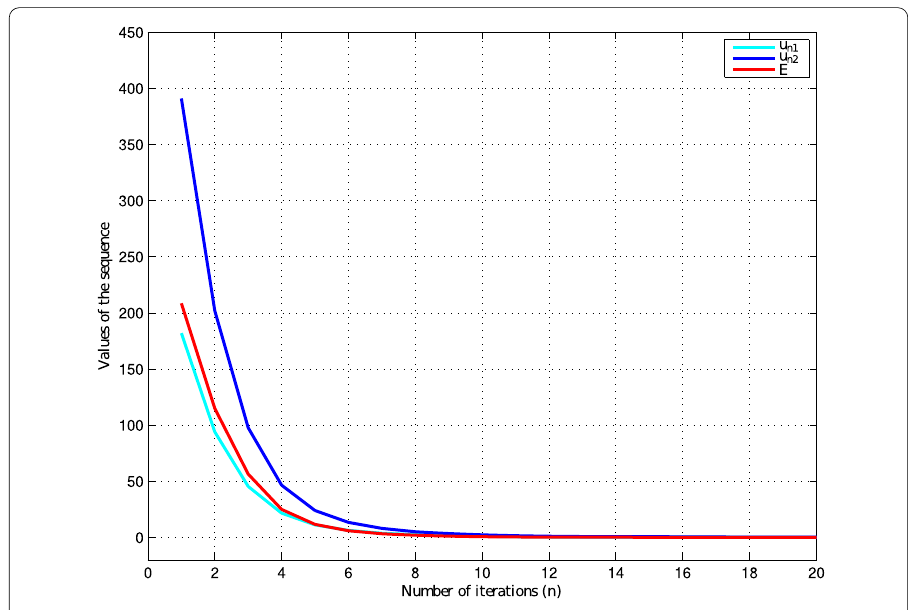
Figure 7 Convergence result of Theorem 3.11 with starting point of Case 3